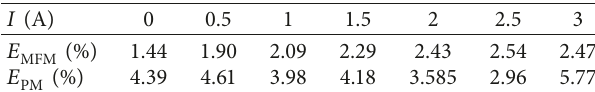
0.01m, f 1 (cid:31) (cid:31)